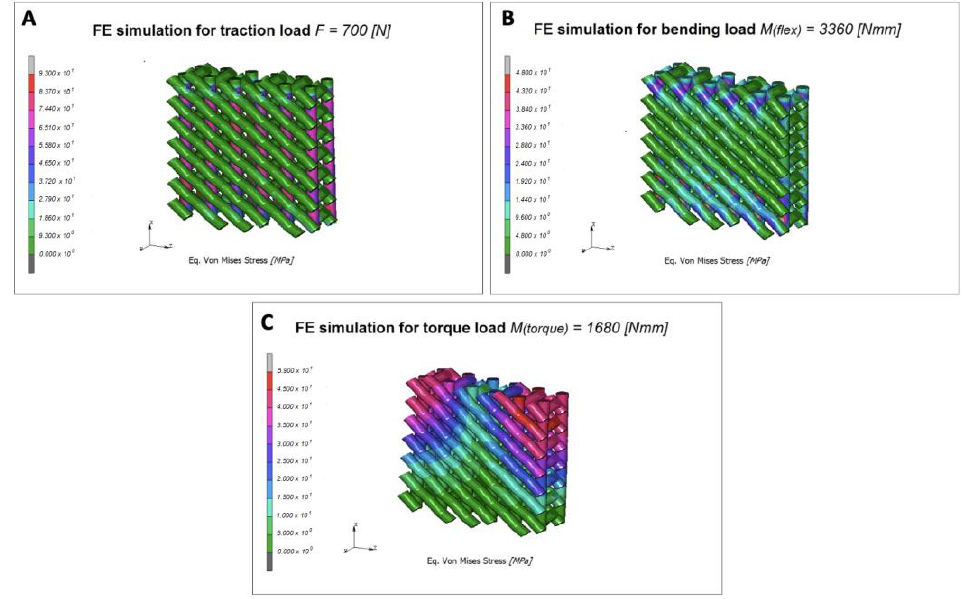
Figure 4. ( A ) Contour maps of eq. Von Mises stress for traction load. ( B ) Contour maps of eq. Von Mises stress for bending load. ( C ) Contour maps of eq. Von Mises stress for torque moment load.